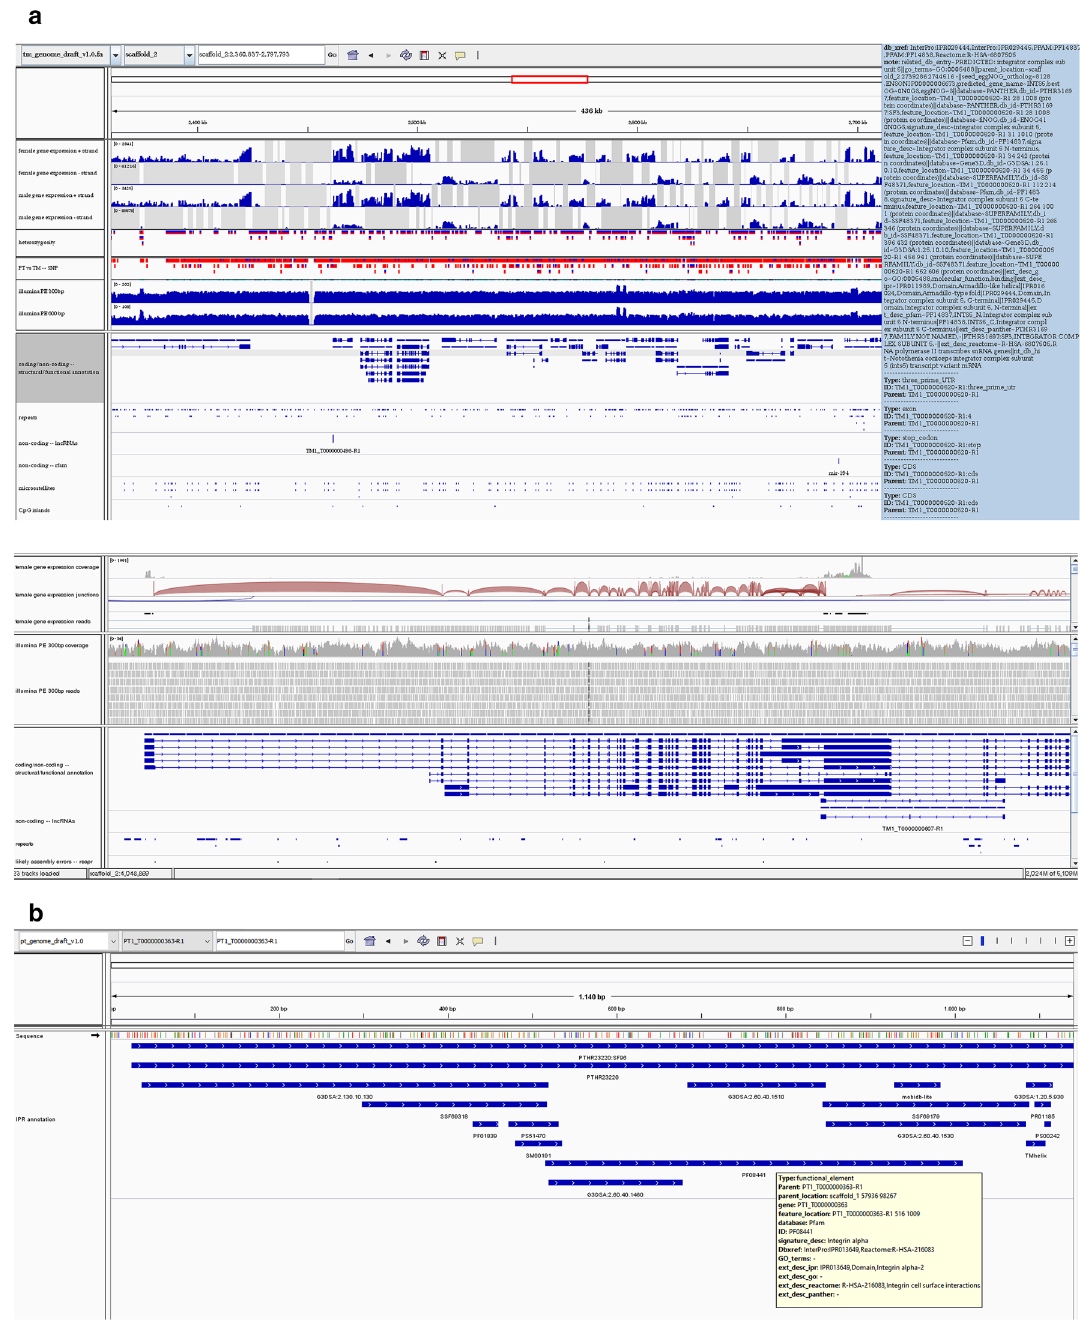
Figure 2. IGV tracks and extended annotation example view. ( a ) The sequences, along with structural and functional information (mouse-over), are provided via IGV tracks. We added an extensive set of data tracks and annotations (not all shown) to facilitate quick downstream analyses. ( b ) Protein sequence-based data set with annotations of identified functional domains (Figures represent screenshots from https ://cichl idgen omes.tugra